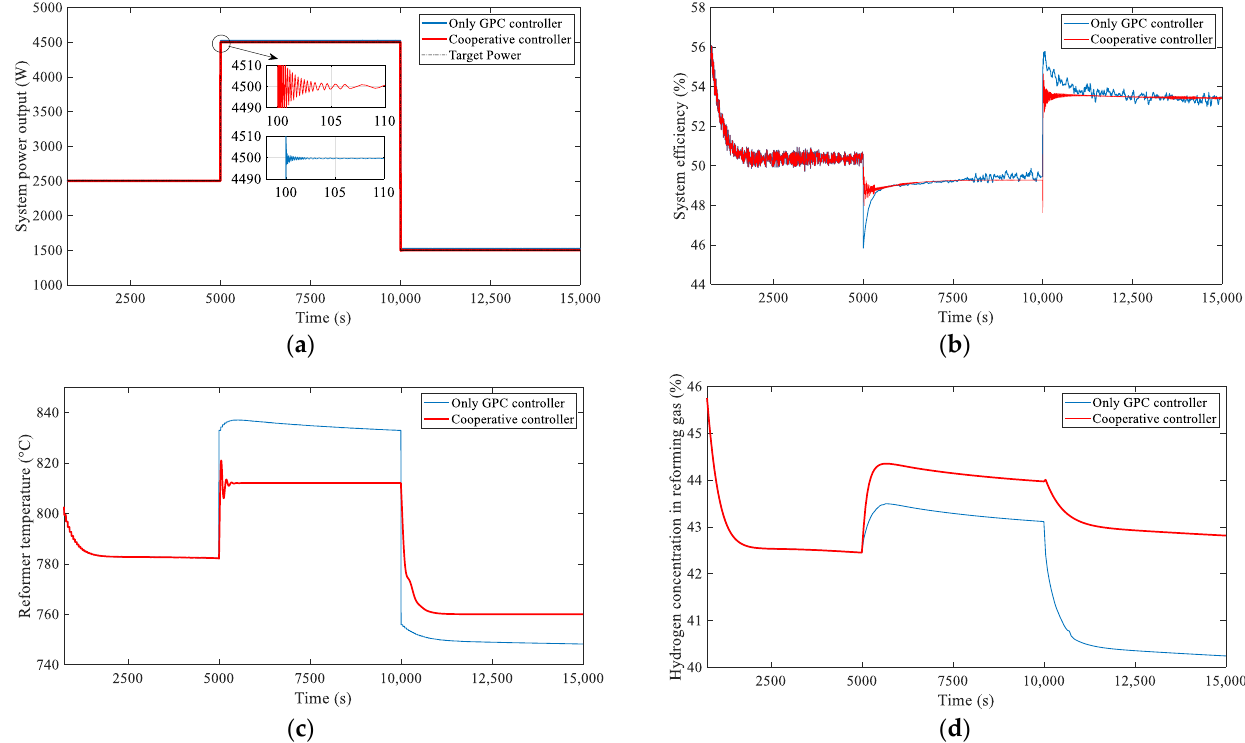
Figure 4. Results under different controllers: ( a ) System power tracking process; ( b ) system efficiency; ( c ) reformer temperature; ( d ) hydrogen concentration in reforming